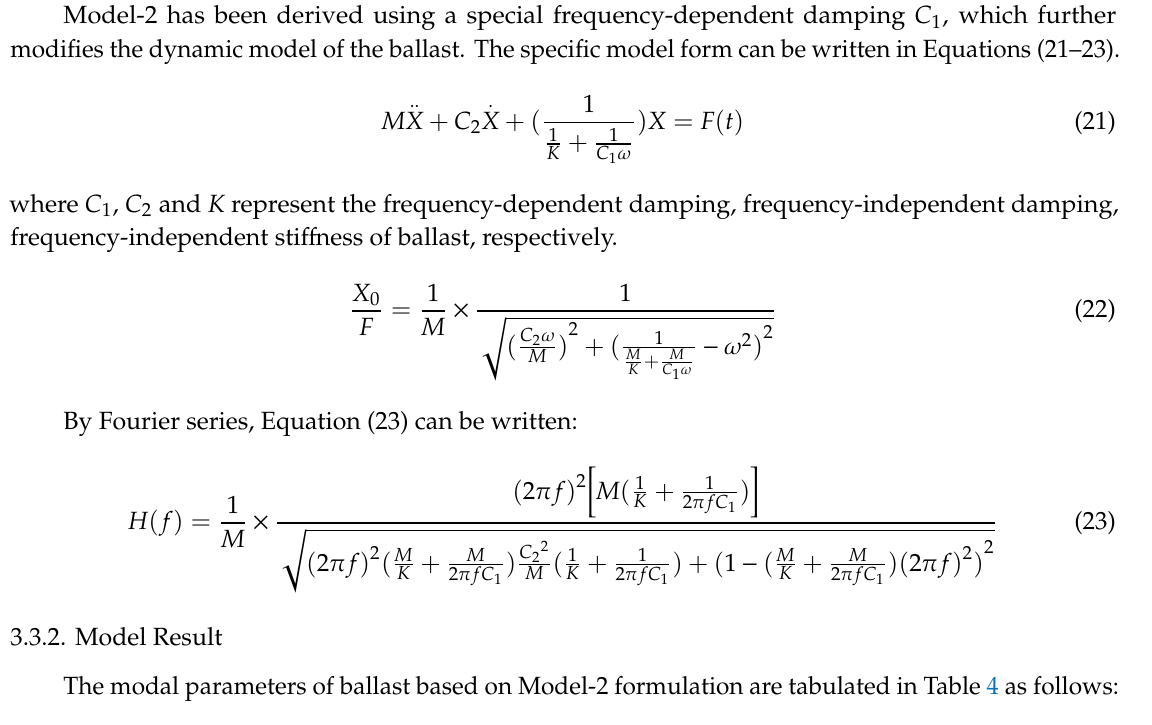
Figure 18. Dynamic damping based on Model-1.